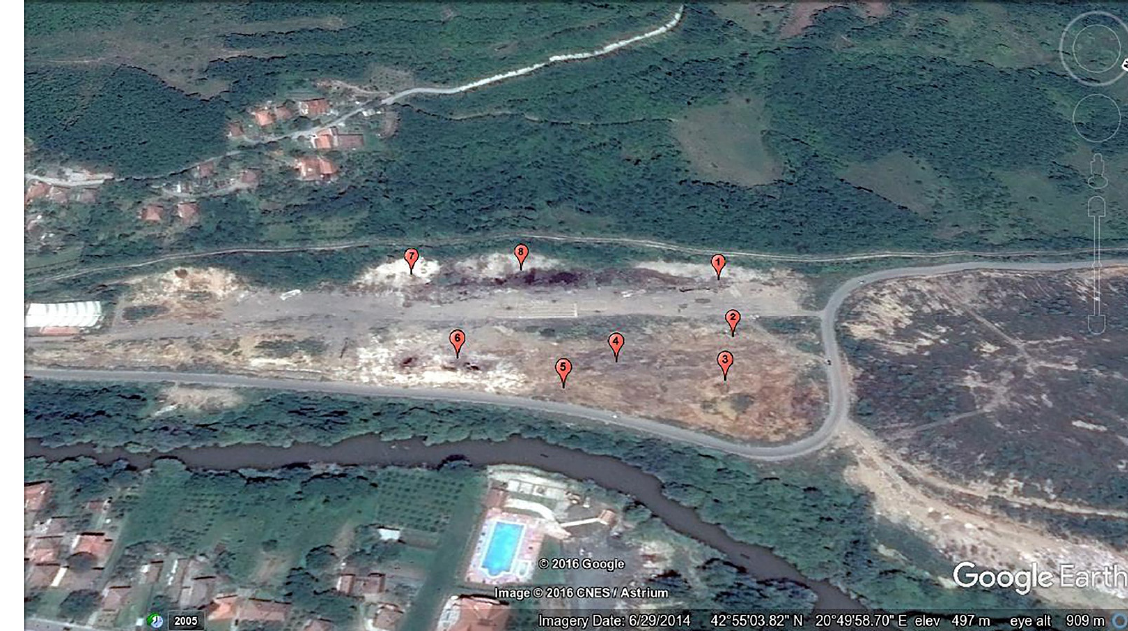
Figure 2. Picture of the tailings with the sampling locations marked.